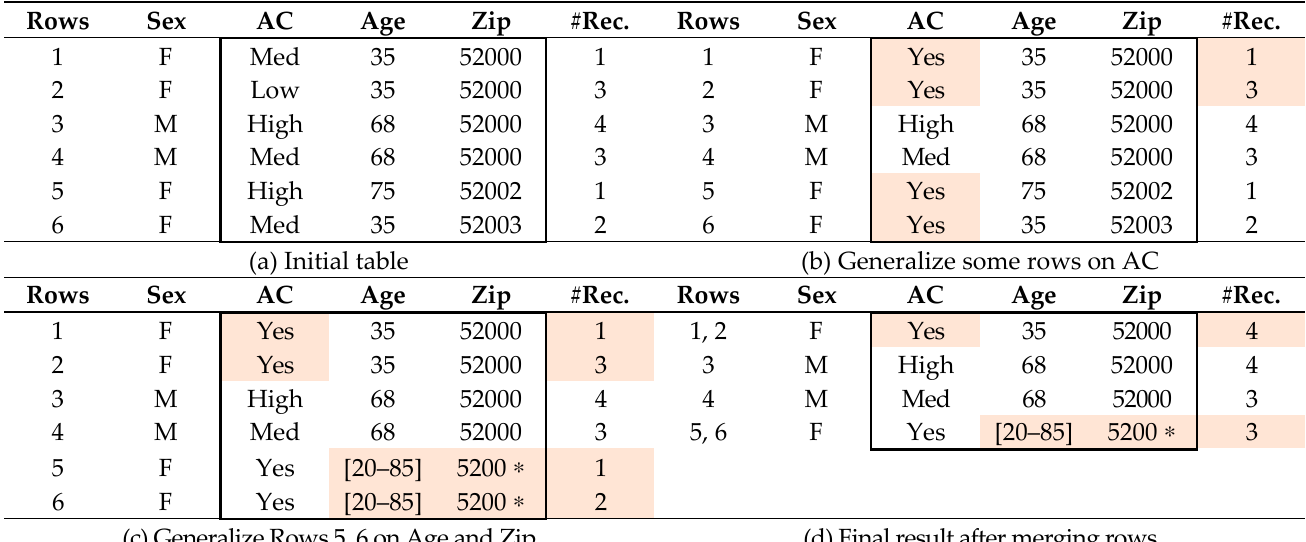
Table 3. Increasing anonymity by generalization on attribute values.